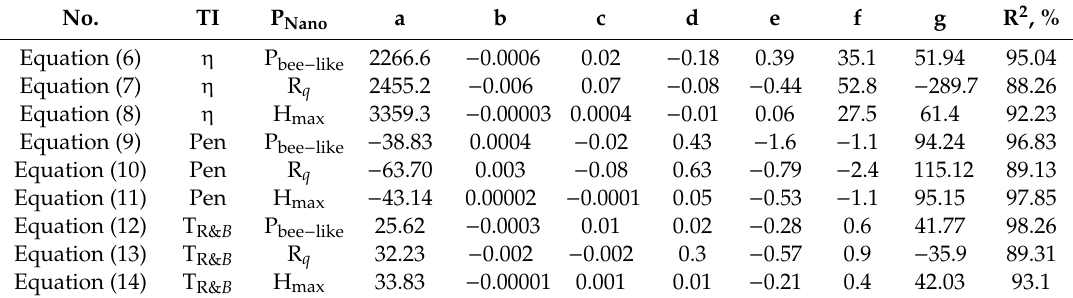
A-90 bitumen technical indexes and nano-morphology parameters relationship fitting